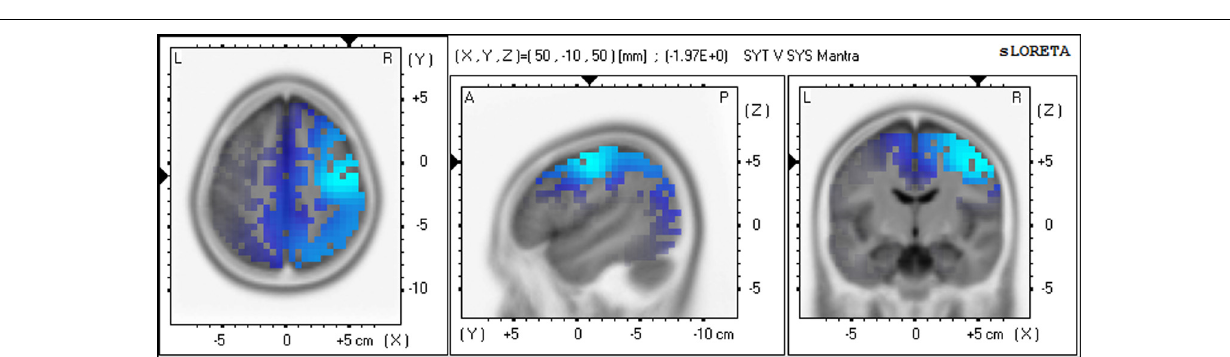
Frontiers in Human